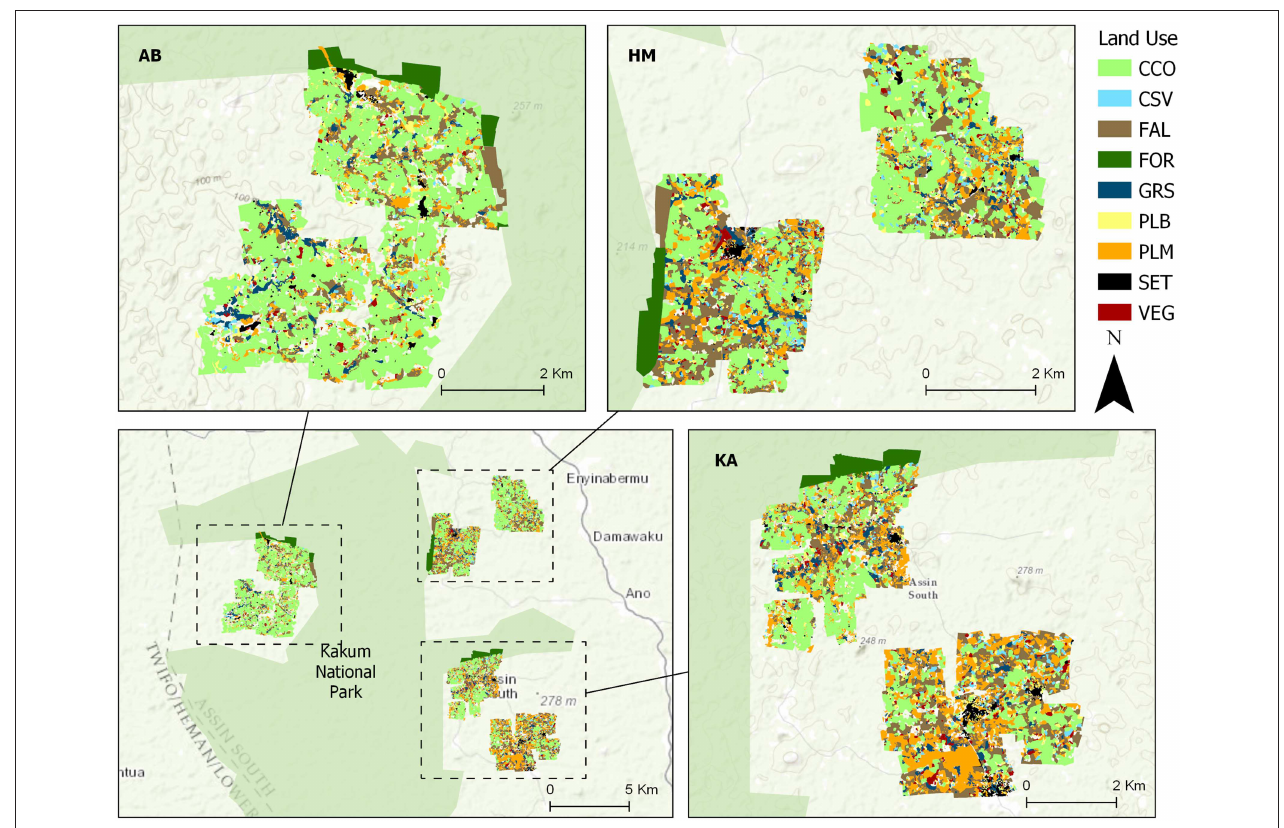
FIGURE 4 | Land use classifications in the Aboabo (AB), Homaho (HM), and Kwameamoabeng (KA) regions of the Central Region of Ghana captured using drone imagery. Land use classifications include cocoa (CCO), cassava (CSV), fallow (FAL), forest (FOR), grassy fallow (GRS), plantain/banana (PLB), palm trees (PLM), settlements (SET), and vegetables (VEG). These communities border Kakum National Park which can be seen in the bottom left inset, depicted in